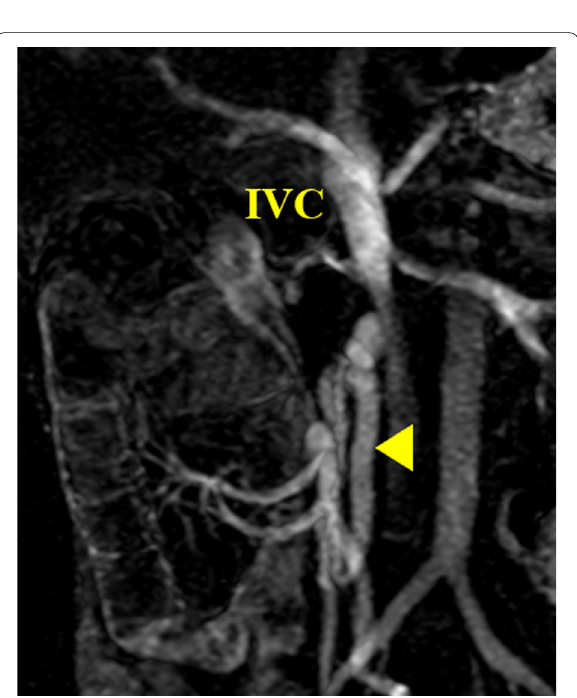
Fig. 6 Postoperative findings of contrast-enhanced magnetic resonance imaging (coronal image). Blood flow in the right testicular vein is maintained (arrowhead) and the shunt is formation and gastrointestinal bleeding due to stenosis or occlusion of the portal vein. Ectopic variceal bleeding is generally massive and life- threatening with a mortality rate of approximately 40%. Up to 17% of ectopic varices occur in the duodenum [8].